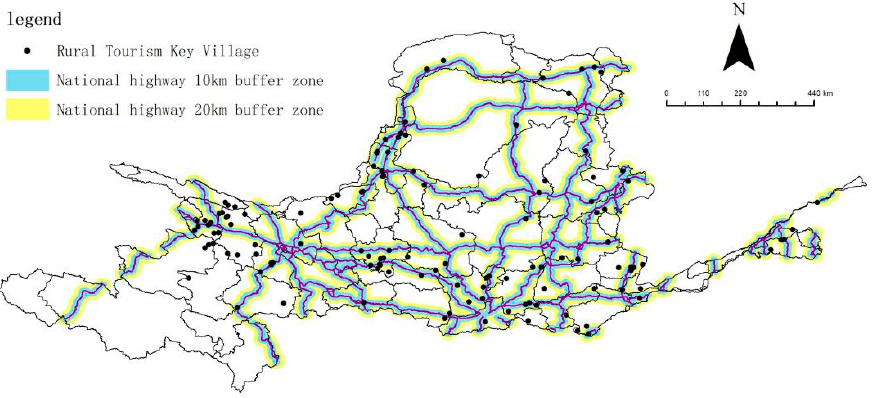
Figure 6. National highway buffer zone map of key rural tourism villages in the Yellow River Basin.